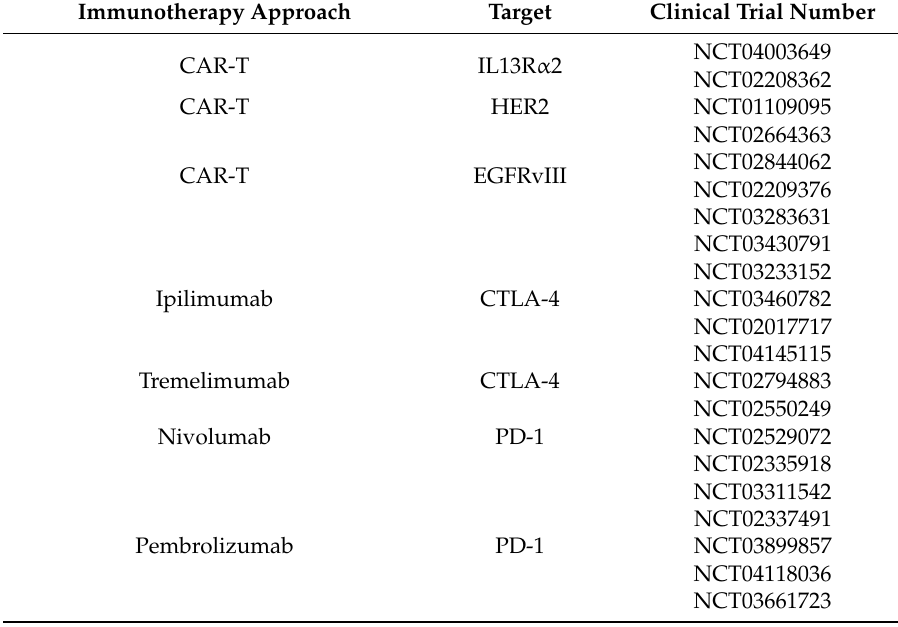
Table 4. Immunotherapeutic approaches in glioblastoma therapies that have entered clinical trials. Not all of the existing clinical trials are presented. Clinical trial numbers were accessed from https: // clinicaltrials.gov /